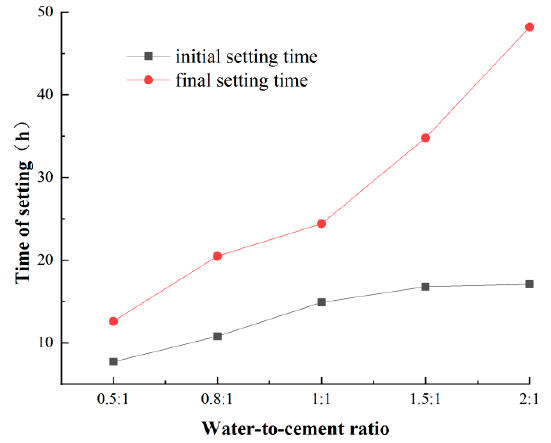
Coatings 2023 , 13 , x FOR PEER REVIEW Figure 2. The influence of the water–cement ratio on the slurry setting time. Figure 2. The influence of the water–cement ratio on the slurry setting time. Figure 2. The influence of the water–cement ratio on the slurry setting time.